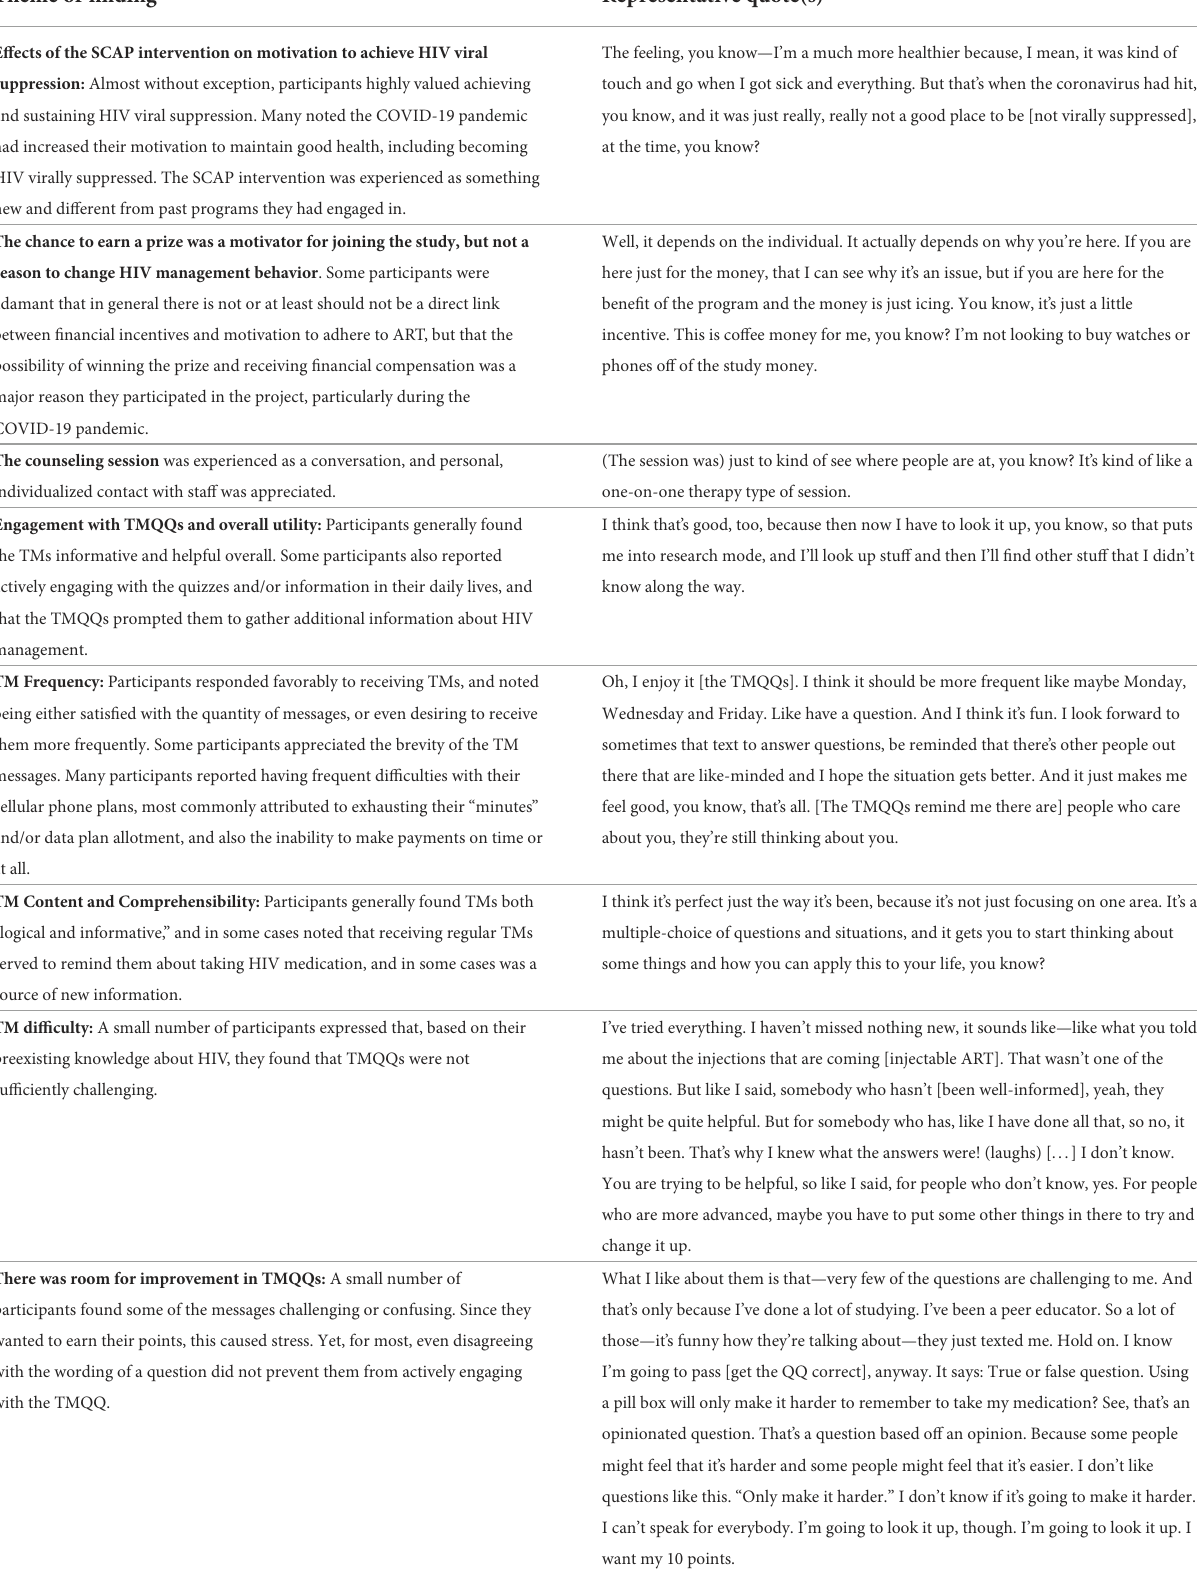
TABLE 7 Summary of qualitative results at check-in contact. Theme or finding Representative